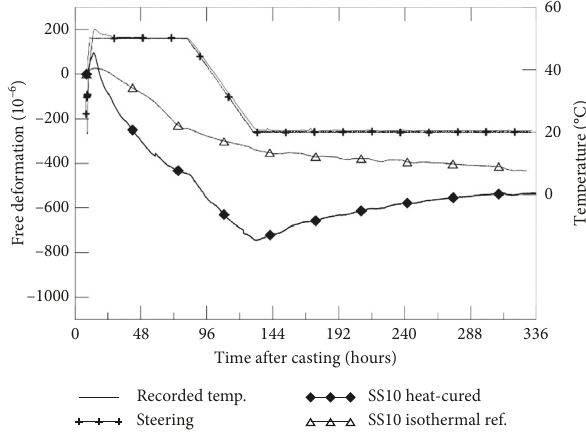
Figure 4: Free deformations and temperature development recorded on SS10 samples.